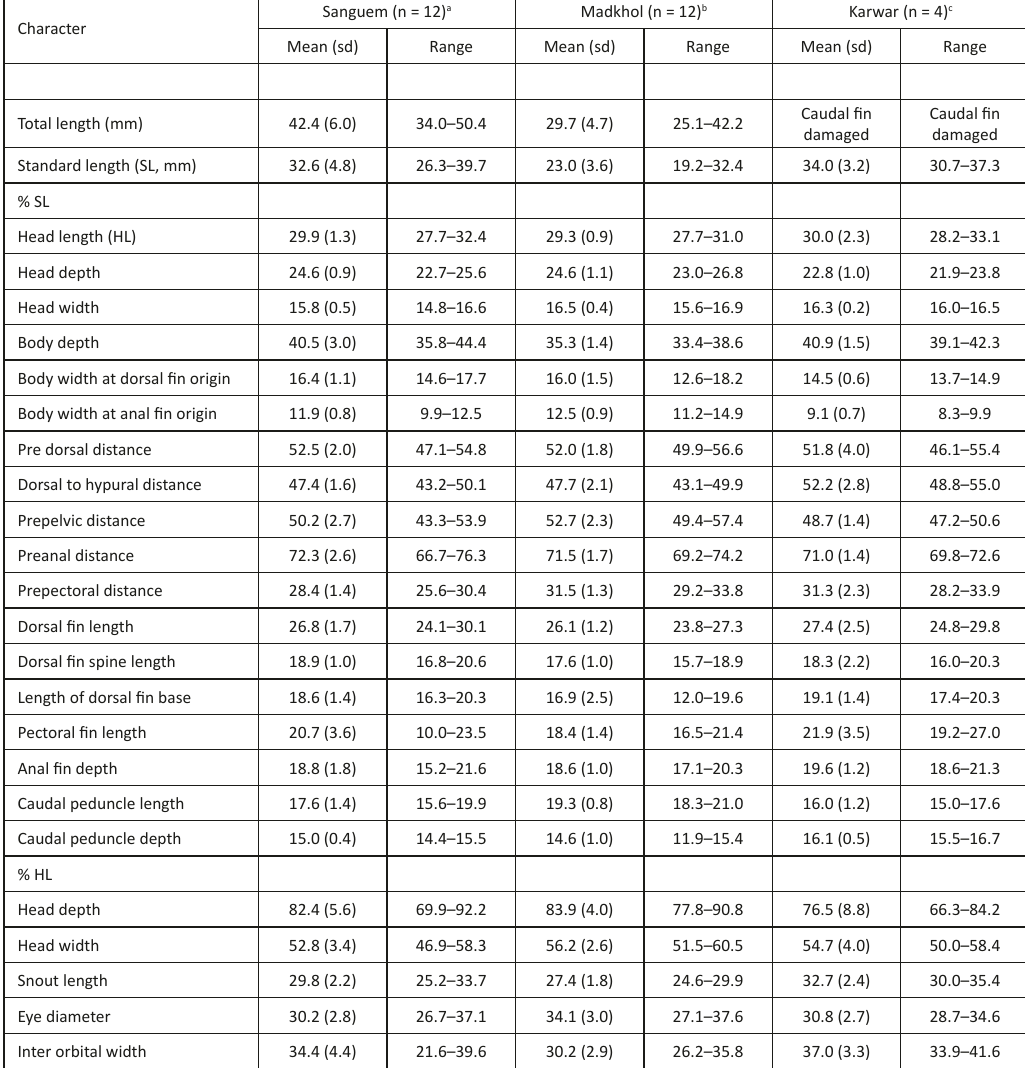
Table 1. Morphometric characters and meristics of Pethia setnai collected from Sanguem, Madkhol and Karwar. Raw data for all the measurements are provided in Appendix A, B and C.